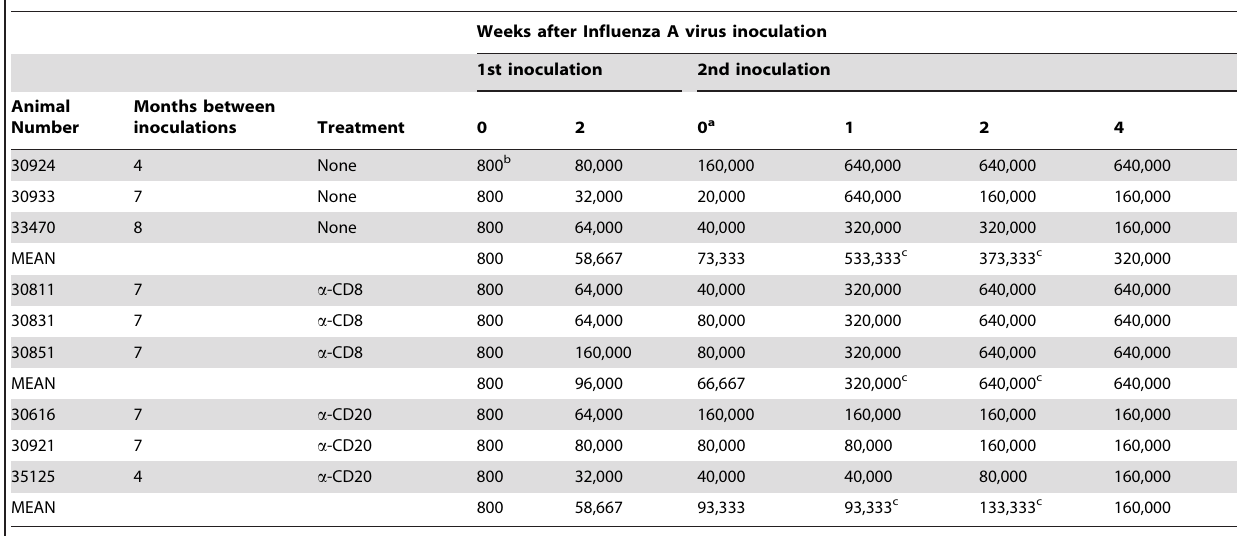
Table 1. IgG titers in plasma after the first and second inoculations withA/Memphis/7/01.